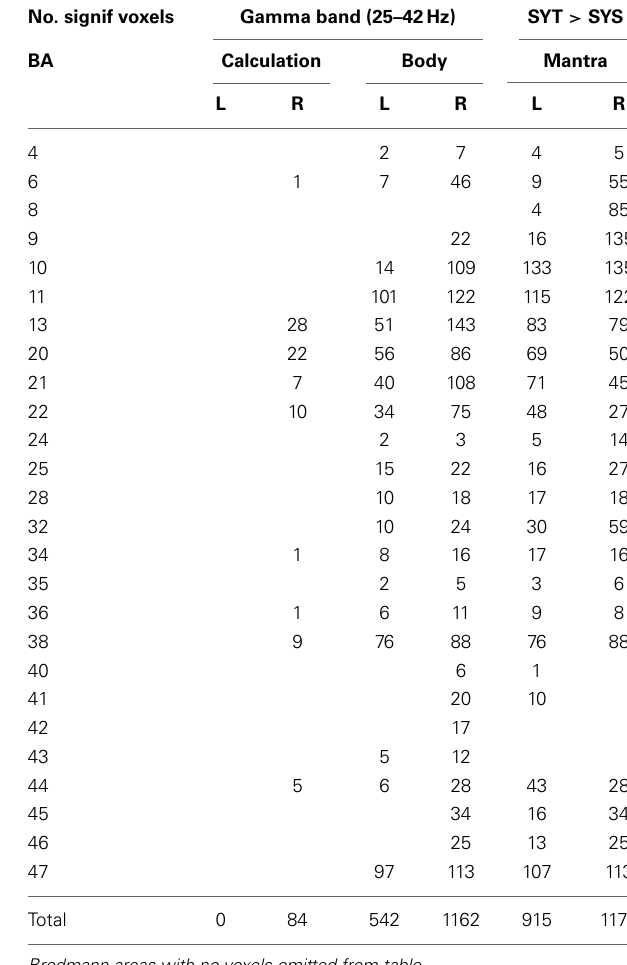
Table 5 | Number of significant voxels in each Brodmann Area for each condition in gamma